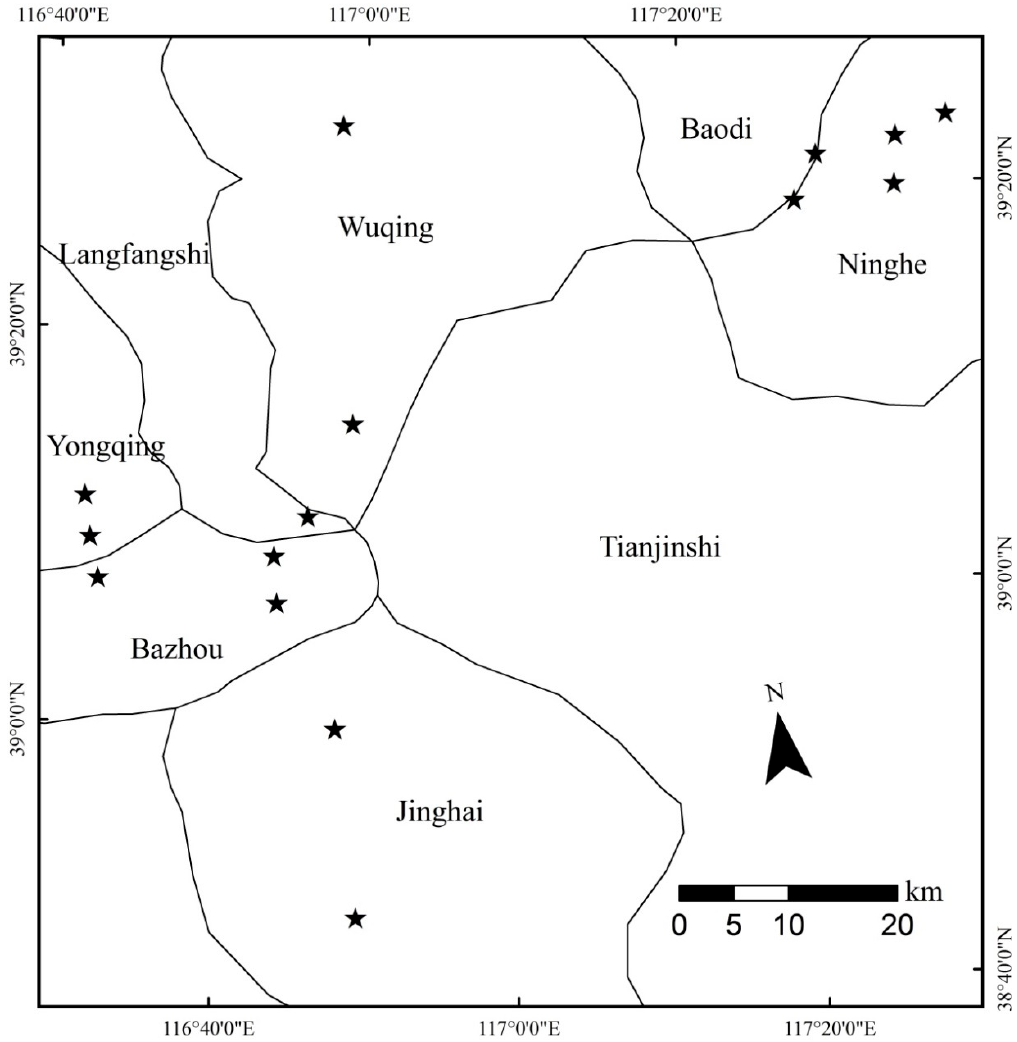
Figure 1. Location of 15 cotton fields in Langfang (Langfangshi, Yongqing and Bazhou) and Tianjin (Baodi, Ninghe and Jinghai) regions.